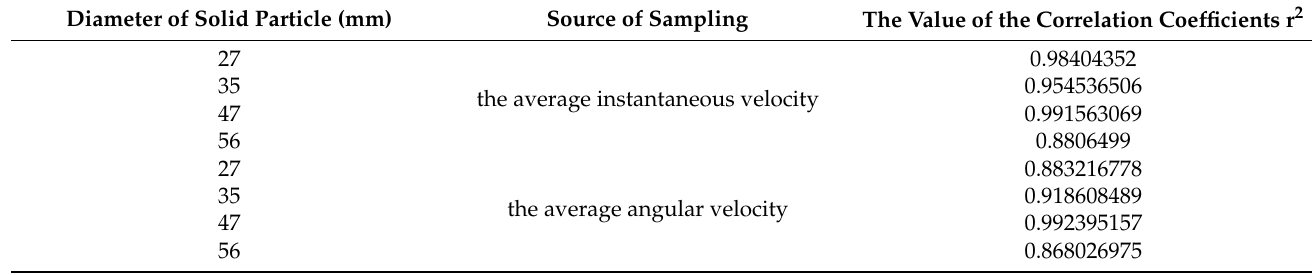
Table 3. The numerical value of the terms in the mathematical equations [44].